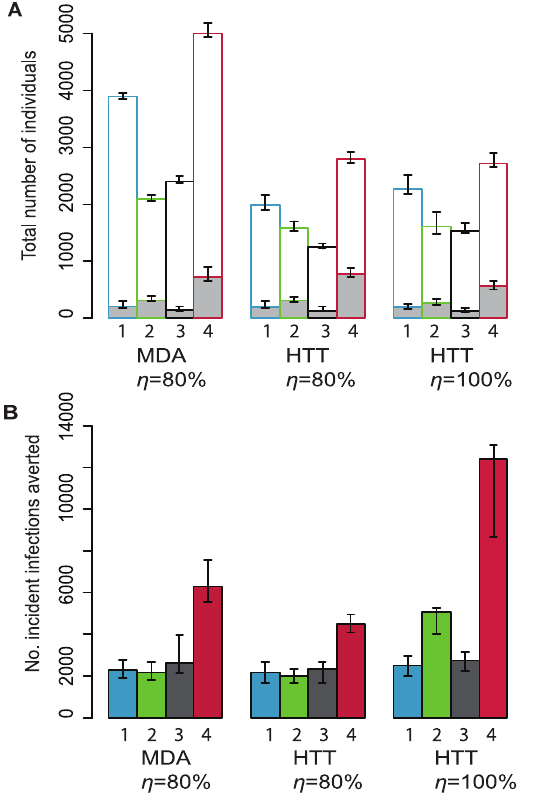
Figure 2. Total number of individuals receiving antibiotics and incident infections averted for MDA compared with HTT. Coloured bars correspond to the different communities: Blue (1) – Upper Saloum District, Green (2) – Jali village, Black (3) – Kahe Mpya sub-village and Red (4) – Maindi village. A) The grey bars correspond to the total number of infected individuals receiving antibiotics and the white bars correspond to the number of uninfected individuals receiving antibiotics. B) The total number of incident infections averted is from the start of treatment through to 5 years after the last round of treatment. For both panels Upper Saloum district, Kahe Mpya sub- village and Jali village have three annual treatment rounds, Maindi village has six biannual rounds. 100 stochastic simulations were run for each scenario and the median of these simulations at each time point are displayed here. The error bars correspond to the inter-quartile range. Therapeutic coverage is donated by g . MDA=Mass drug administration. HTT=Household targeted